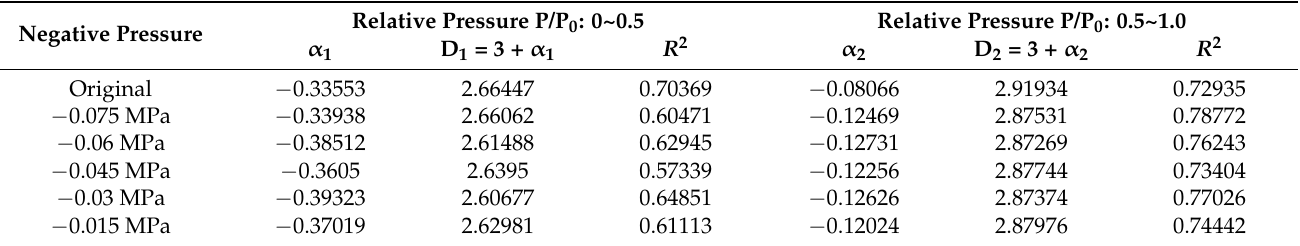
Table 4. Calculation results of the fractal dimensions of the adsorption pores based on the FHH fractal model.